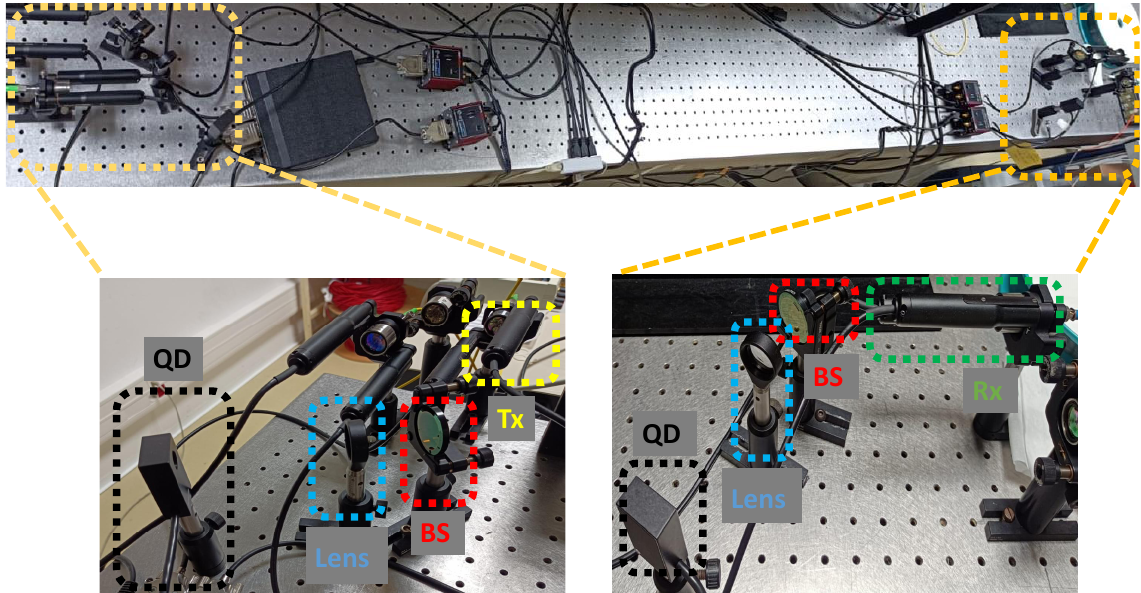
Figure 7. Picture of the experimental setup used for bidirectional